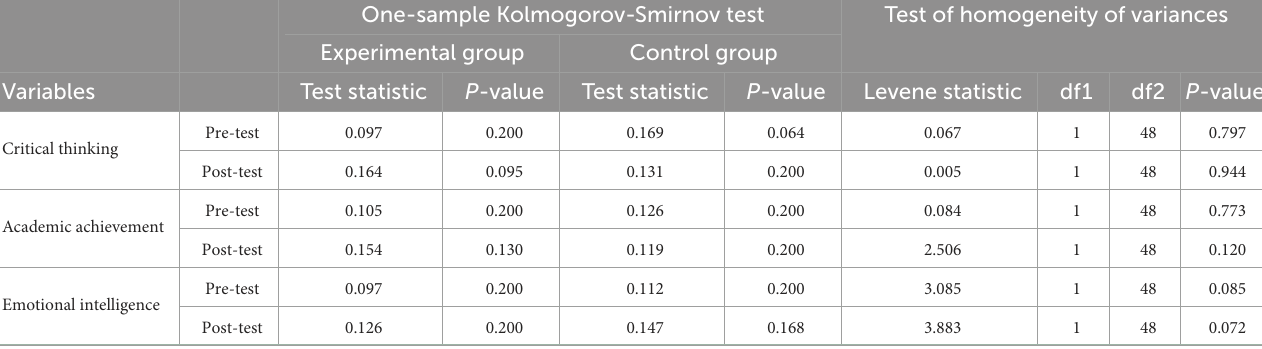
TABLE 2 Data normality test and variance